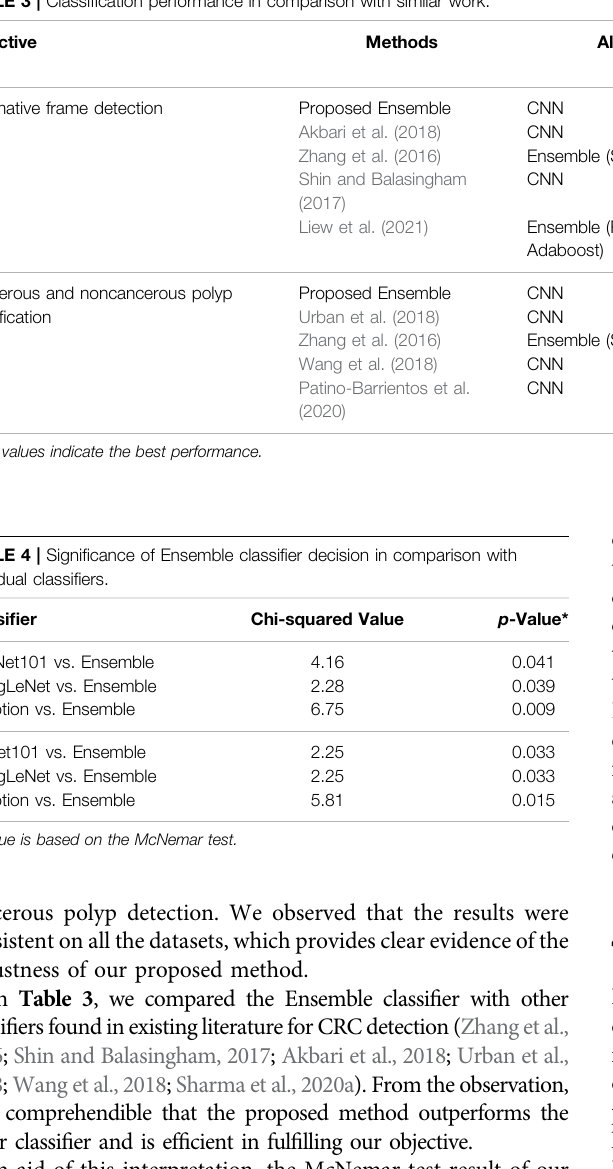
TABLE 3 | Classi fi cation performance in comparison with similar work. Objective